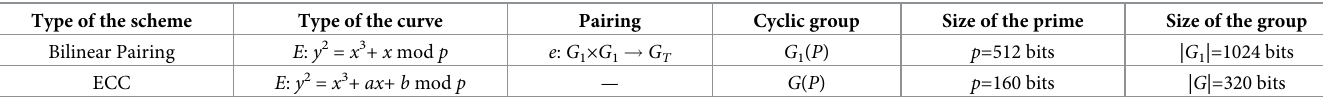
Table 4. Length of parameters in bilinear pairing and ECC. Type of the scheme Type of the curve Pairing Cyclic group Size of the prime Size of the